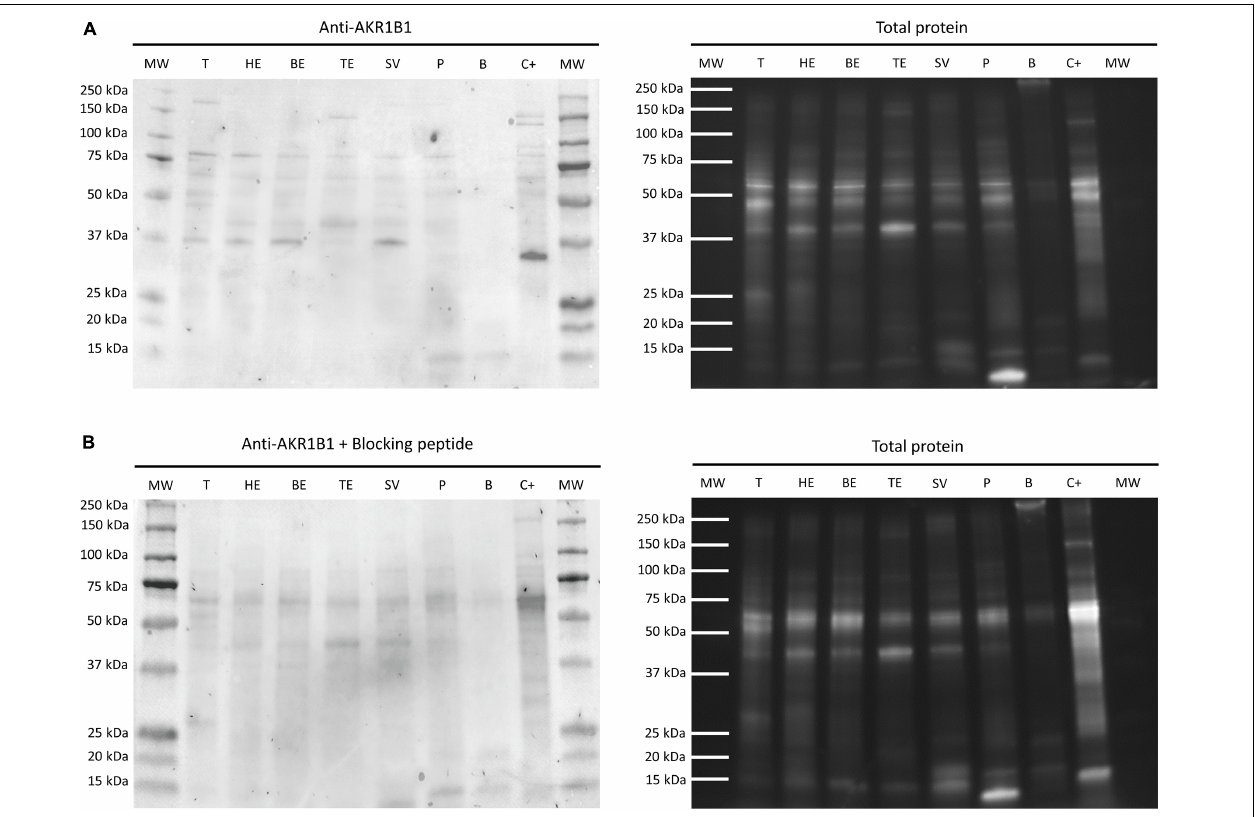
FIGURE 2 | Representative Western blot of (A) anti-AKR1B1 and (B) its corresponding blocking peptide, and their total protein controls in boar reproductive tissues. MW, molecular weight; T, testis; HE, caput epididymis; BE, corpus epididymis; TE, cauda epididymis; SV, seminal vesicles; P, prostate; B, bulbourethral glands; C+,